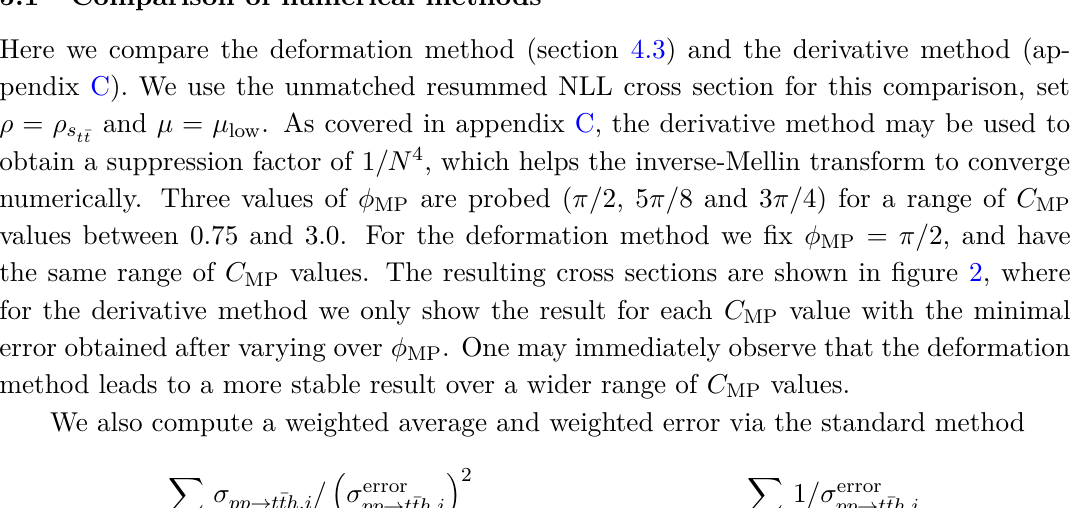
Figure 2 . Left: the NLL cross section with ρ = ρ s the numerical error bars, computed using the derivative (red) and the deformation (blue) methods. The dashed line indicates the average cross section obtained via eq. (5.1), and the band the weighted numerical error. Right: contribution of the boundary terms of the derivative method for different values of C . The dashed red line indicates the average boundary contribution, and the band the MP error computed via eq.